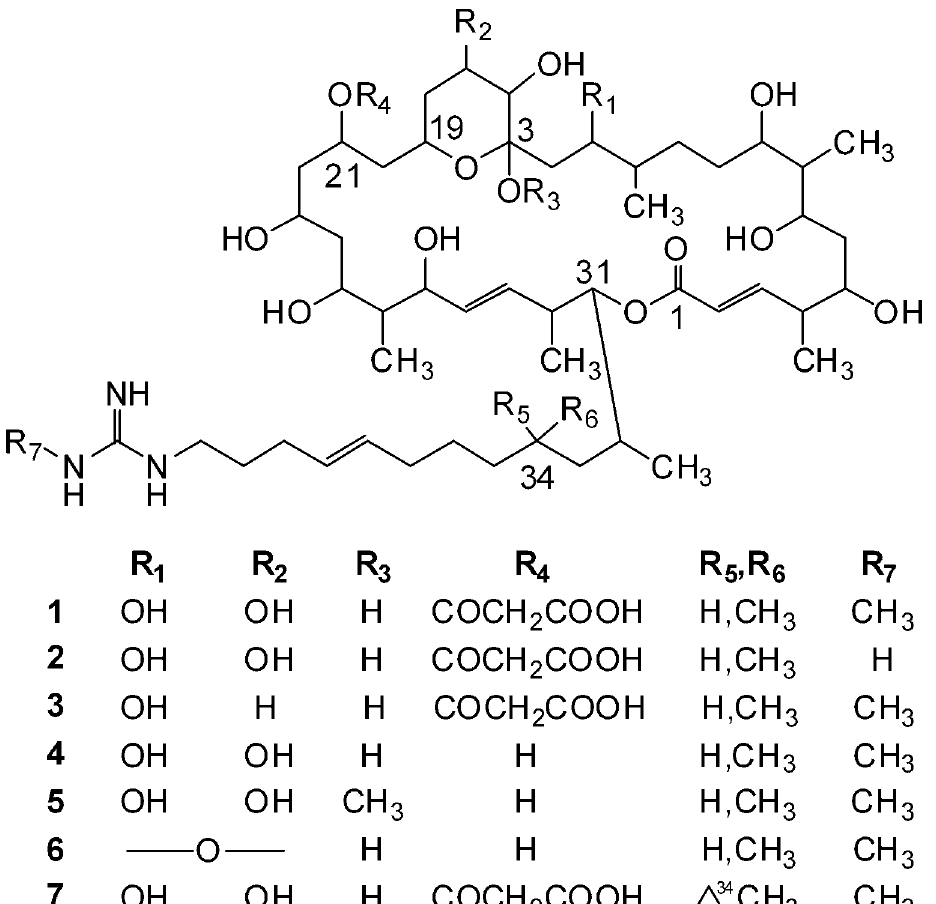
Figure 1. Chemical structures of 32-membered guanidine-containing polyhydroxyl macrolides ( 1 – 7 ).